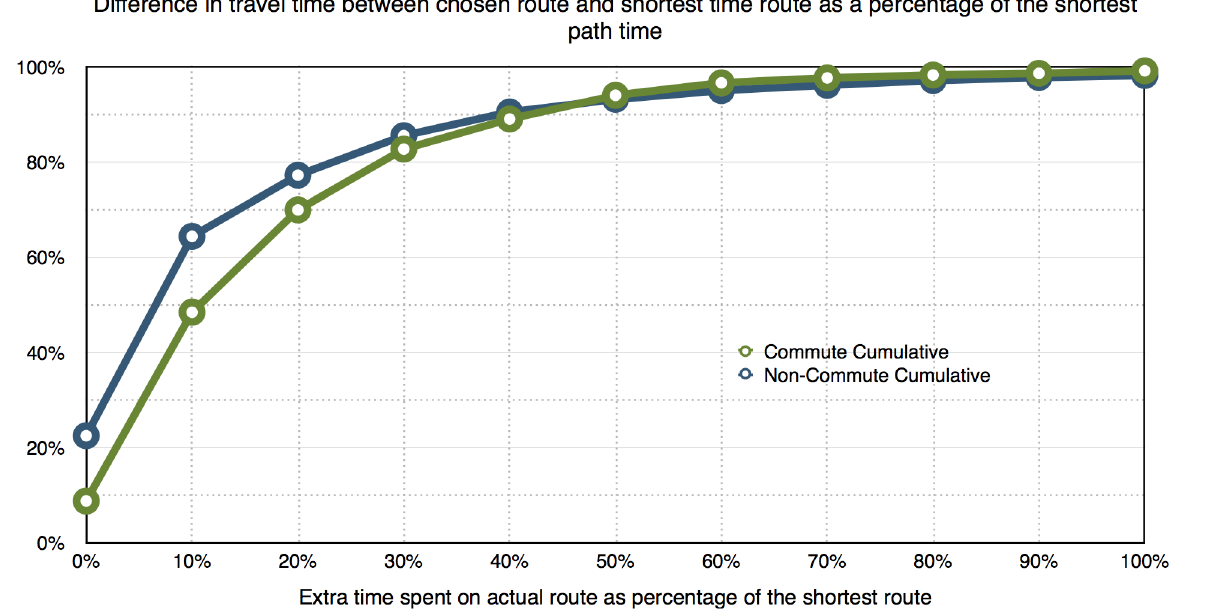
Fig 4. Difference in travel time between chosen route and shortest time route as a percentage of the shortest path time.